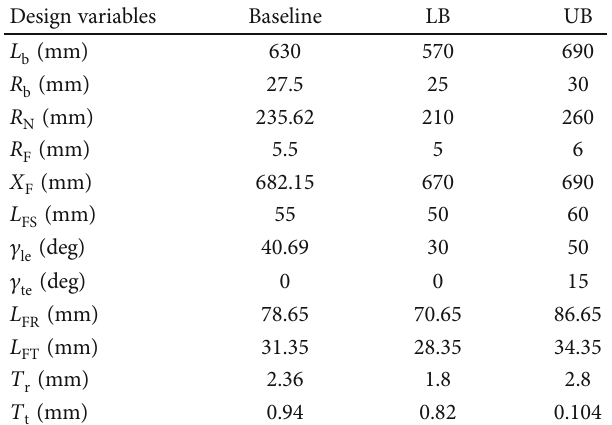
Figure 11: Design variables of the missile: (a) body and nose and (b) tail fi n. Table 2: Baseline, lower, and upper values of the design